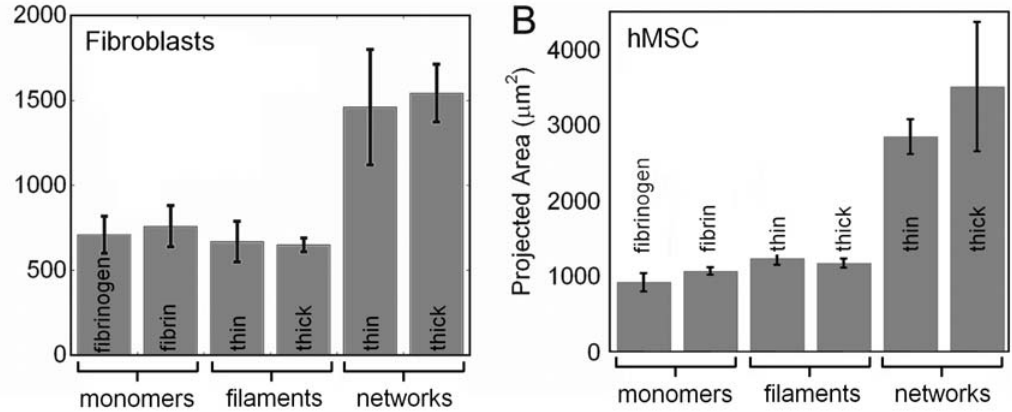
Figure 2. Cells spread on ‘‘soft’’ polyacrylamide only if coated with a continuous fibrin network. Spread area of fibroblasts (A) or hMSCs (B) cultured for 18 hours on 100 Pa polyacrylamide gels coated with either fibrinogen monomers, fibrin monomers, thin fibers, thick fibers, a network of thin fibers or a network of thick fibers. Reported as mean 6 SE, n=3, at least 50 cells per group.